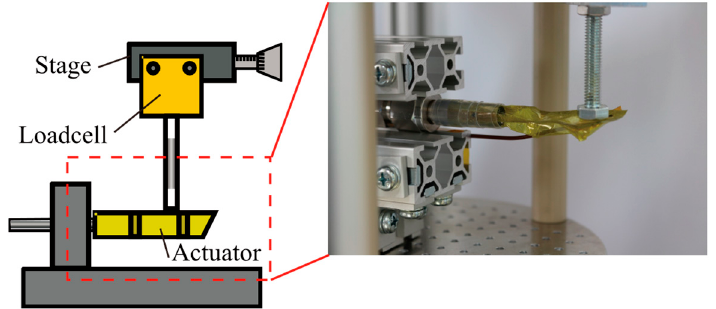
Figure 16. Measuring setup of torque and pressure evaluation.